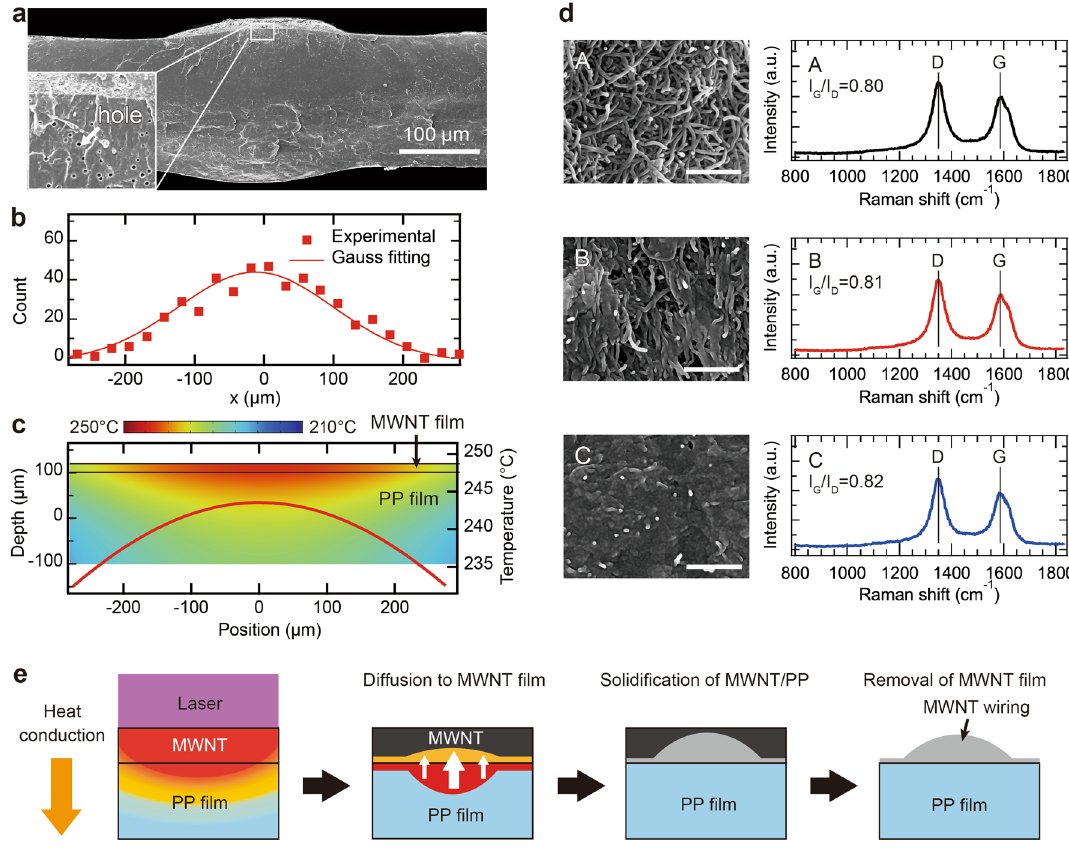
Figure 4. ( a ) XSEM images of MWNT wiring (laser power 66 mW, scanning speed 0.05 mm/s). ( b ) Hole density distribution in PP. ( c ) Temperature distribution in PP simulated with COMSOL Multiphysics. ( d ) Top- view SEM images and Raman spectra of the MWNT wiring with a laser power of 66 mW and a scanning speed of 0.05 mm/s at center to edge in the wiring. A, B, and C indicate the center, middle, and edge of the MWNT wiring, respectively. Scale bars are 0.5 μm. ( e ) Speculated formation mechanism of MWNT